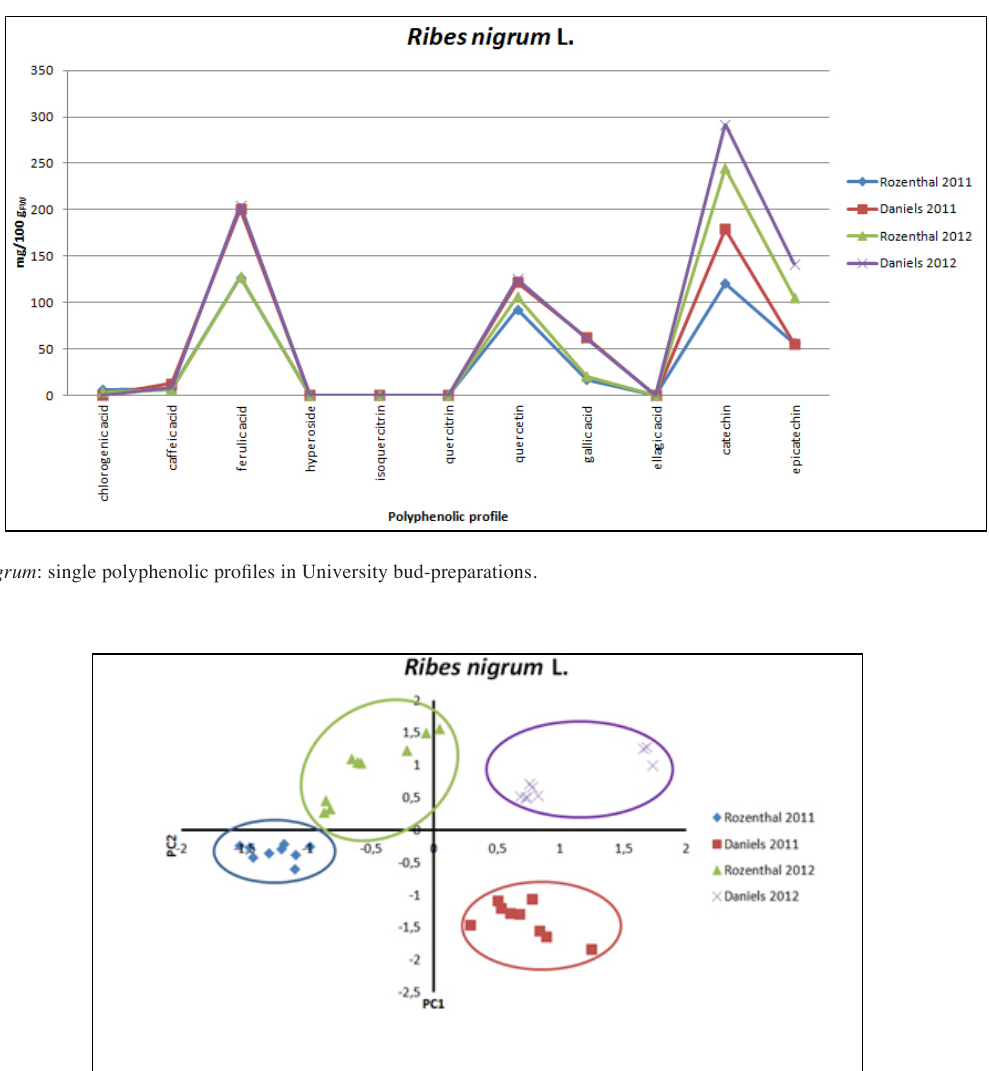
(ellagic acid, Kiowa 2011) (Fig. 6). There were statistically significant differences among the University and company bud- preparations samples, but in this second case differences were not observed in cinnamic acids and